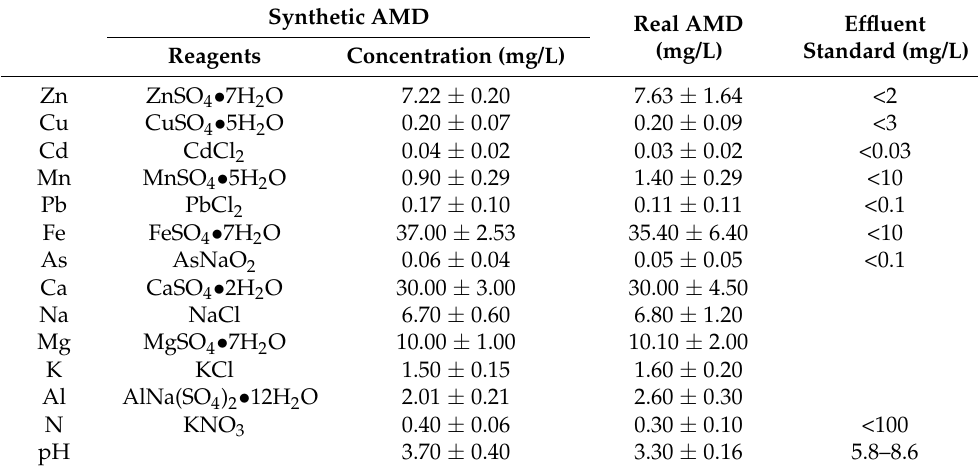
Table 1. Chemical composition of AMD (avg ± SD, n = 27) and the effluent standard in Japan. Synthetic